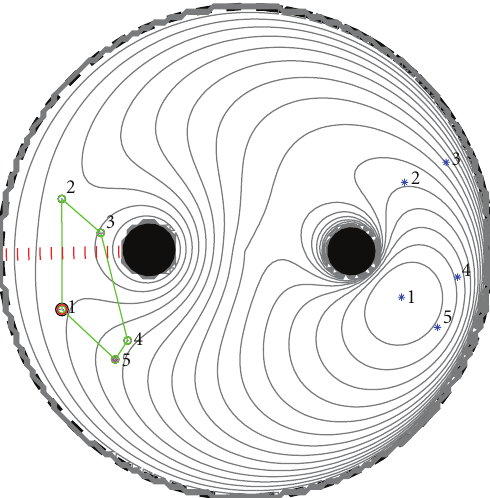
Figure 11: An illustration of an infeasible